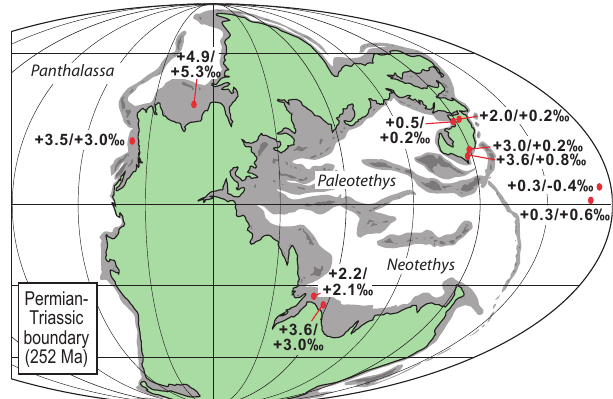
Fig. 7. Average δ 15 N sed for Upper Permian (left) and Lower Tri- assic (right) units. Upper Permian δ 15 N sed varies from low values in the central Panthalassic Ocean ( + 0.3‰) to intermediate values in the Tethyan region and high values on the northwestern Pangean margin ( + 4.9‰), probably owing to higher rates of water-column denitrification in the latter regions. Note that all Permo–Triassic δ 15 N sed values globally are intermediate relative to the low values characteristic of the Cenomanian–Turonian boundary or the high values characteristic of the Carboniferous (Fig. 1). Site-specific changes in δ 15 N sed across the PTB range from − 2.8‰ to + 0.4‰ with an average of − 0.9‰, which is consistent with our hypothesis of intensified sedimentary denitrification during greenhouse climate intervals such as the Early Triassic. Data sources in Table 1 with ad- ditional data from S. Schoepfer and T. Algeo (unpubl. data).